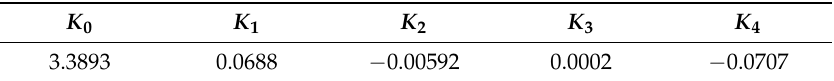
Table 1. The identification result of k 0 , k 1 , k 2 , k 3 , k 4 .